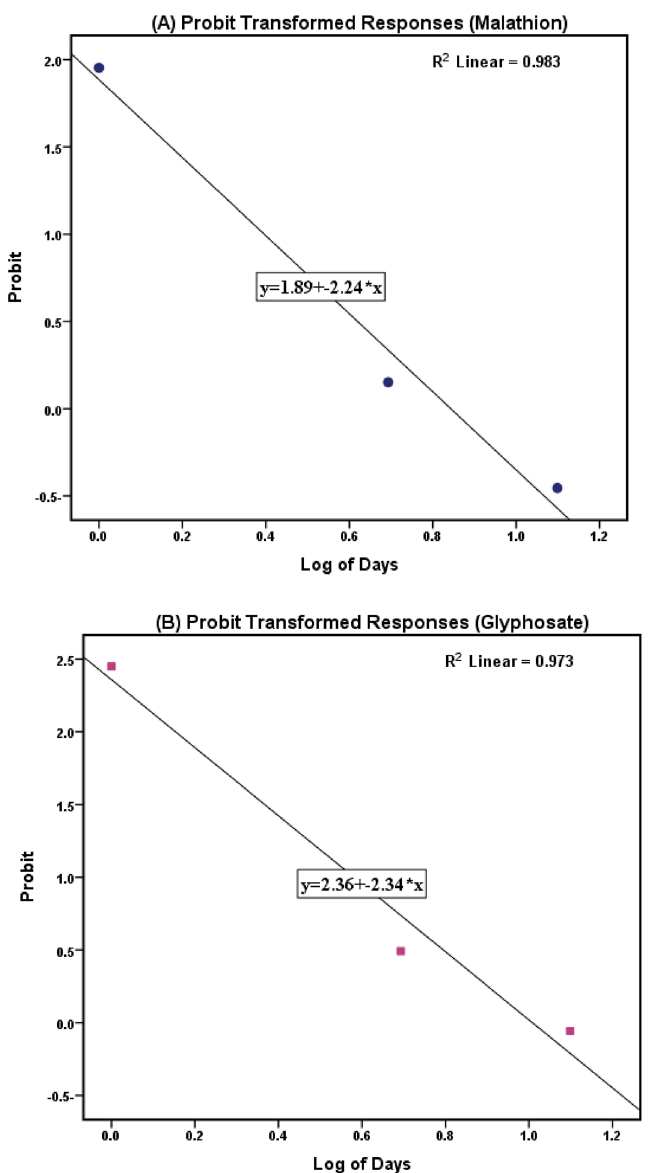
Figure 2. Probability for half-life of Glyphosate and Malathion mg L −1 in natural log days using Probit